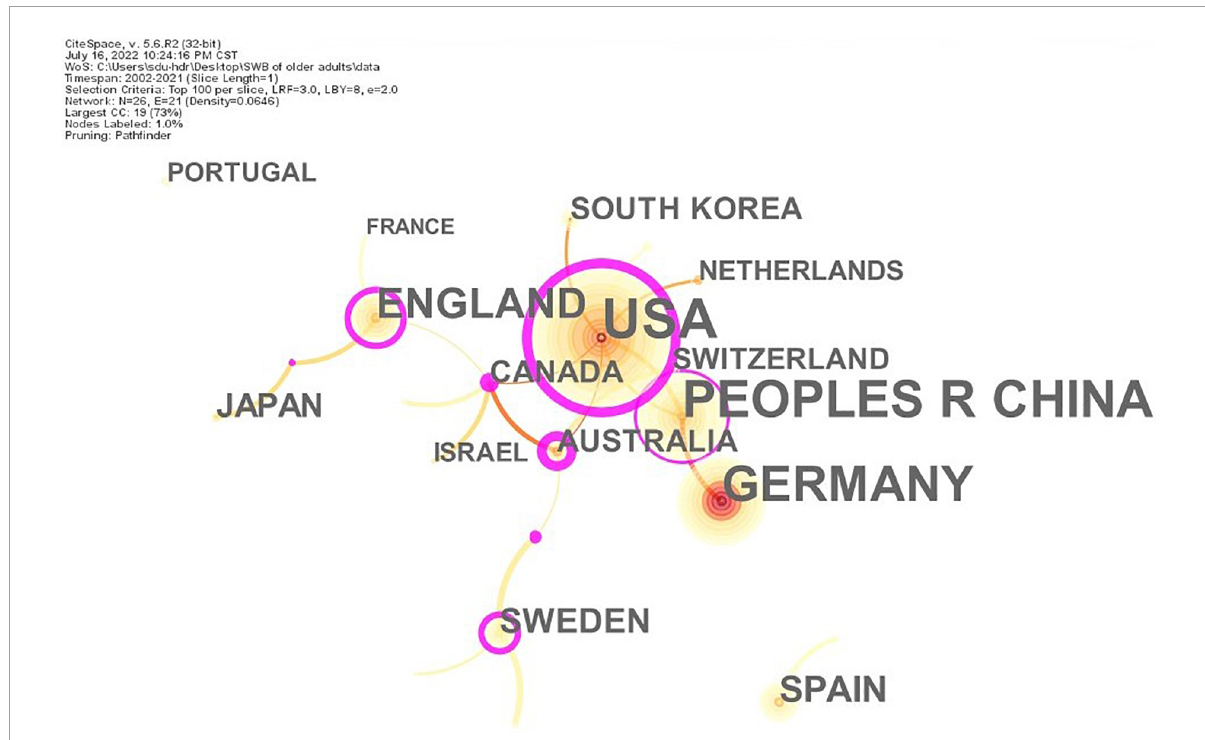
FIGURE5 Co-authorship network of countries. A circle represents a country, and the size of the circle represents the frequency of publications. The connection between nodes represents the cooperation relationship, and the thickness of the connection represents the frequency of cooperation. The purple edge of the node indicates high betweenness centrality ( ≥ 0.1).